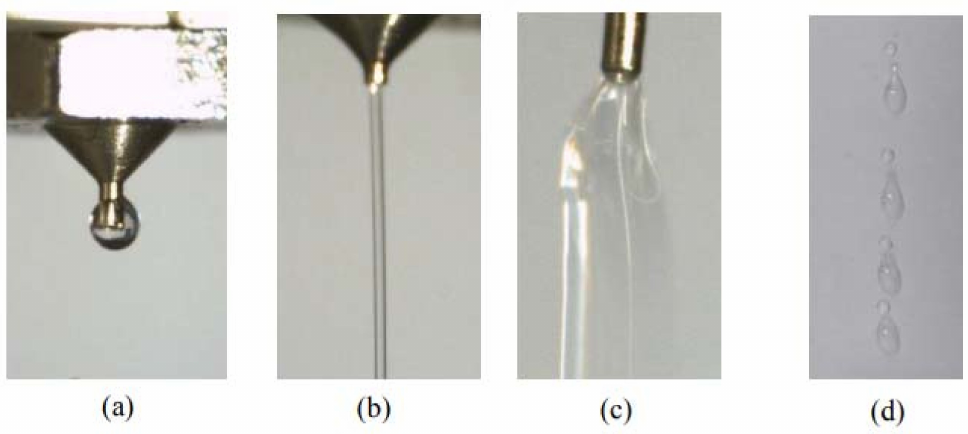
Figure 15. Jetting failure situations: ( a ) adhesion; ( b ) flow-stream; ( c ) sputtering; ( d ) satellite